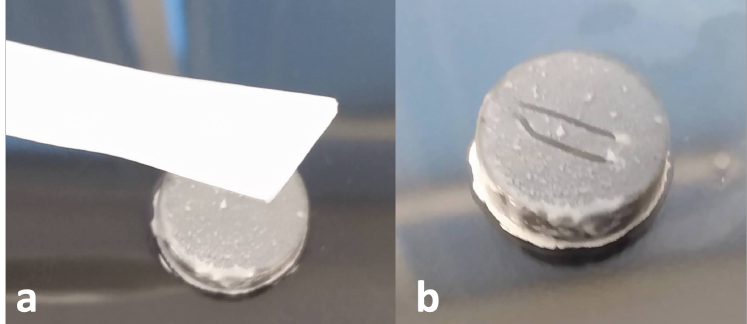
Figure 3. ( a ) Cell lifter next to Ti coupon with 72 h of S. aureus biofilm growth ( b ) Ti coupon after two 7 mm long streaks of biofilm have been removed from the surface. The lines avoid the edges of the coupon where the most inconsistent/variable biofilm growth occurs.